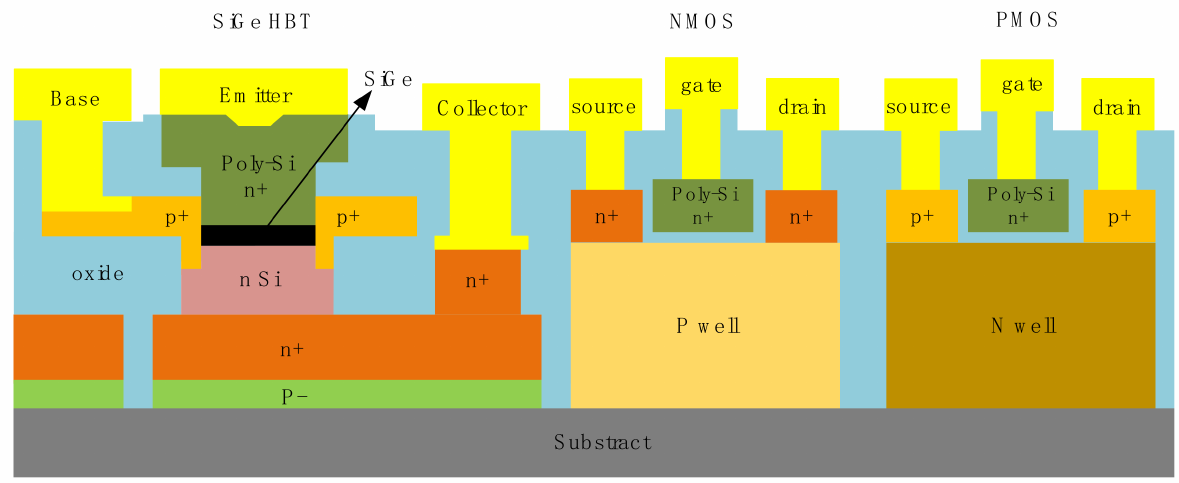
Figure 5. SiGe BiCMOS structure